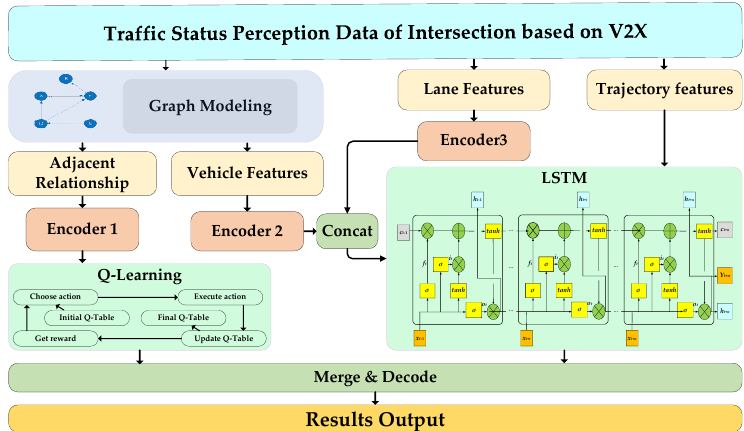
Figure 3. Structure of improved LSTM model for ICVs.